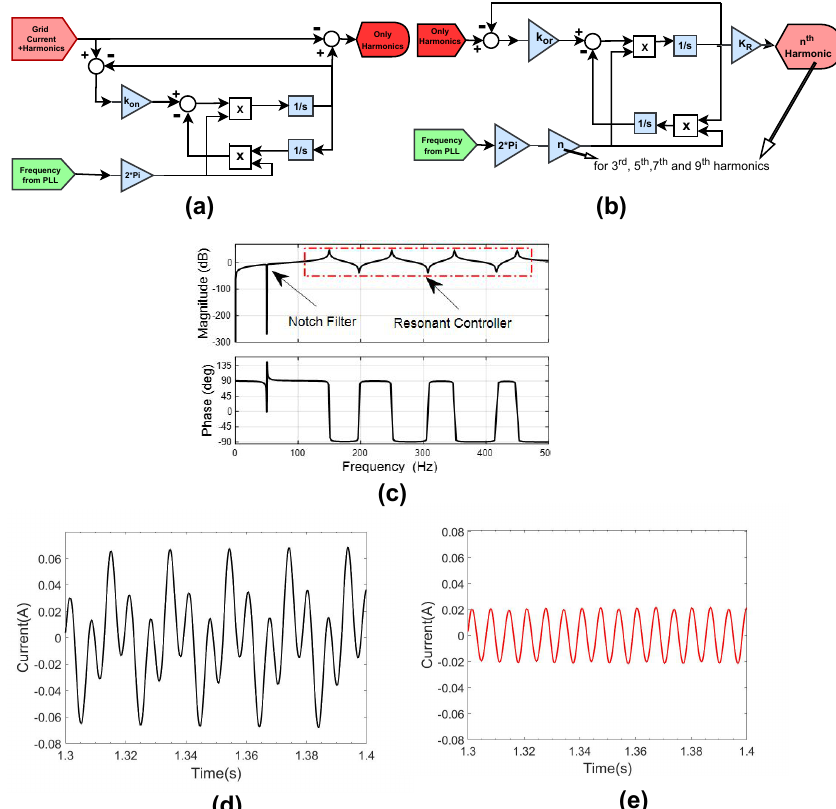
Figure 10. Adaptive resonant controller for harmonic compensation. ( a ) adaptive notch filter for blocking of fundamental current ( b ) adaptive resonant harmonic compensator ( c ) Frequency response of notch filter and resonant harmonic compensator ( d ) without using notch filter detection of 3rd Harmonic in i g ( e ) After using notch filter detection of 3rd Harmonic in i g .